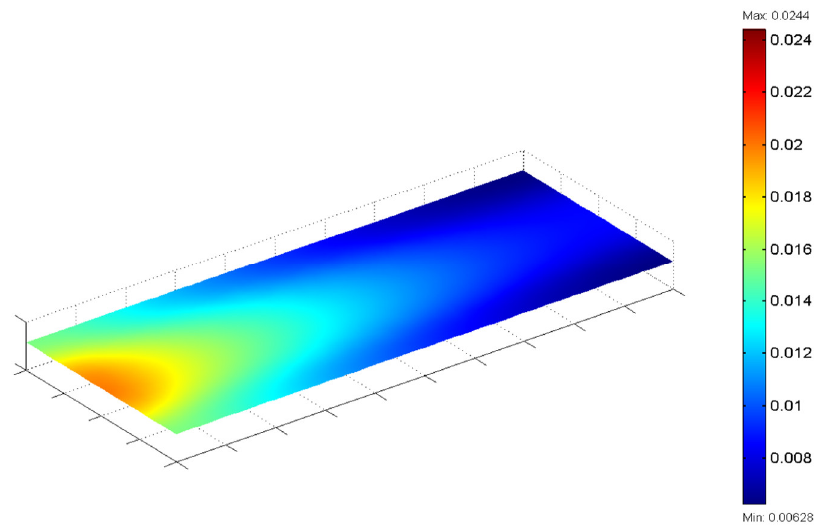
Figure 19. Variation of diffusion overpotential at the CCL at peak power.